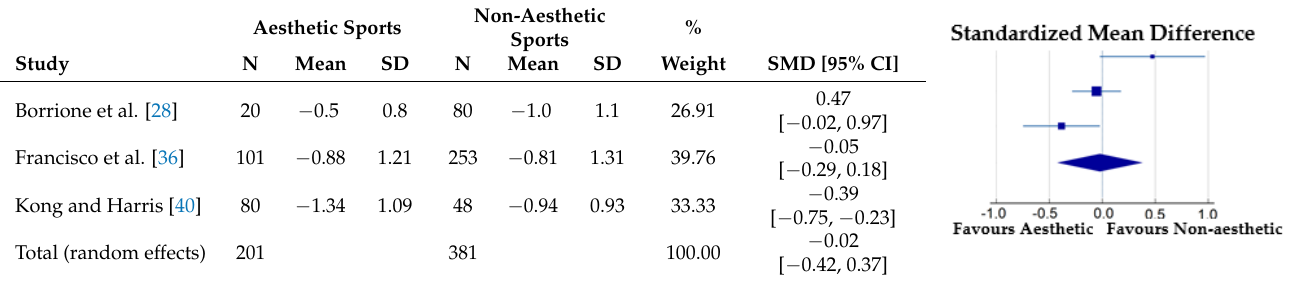
Table 3. BID by type of sports in female athletes.